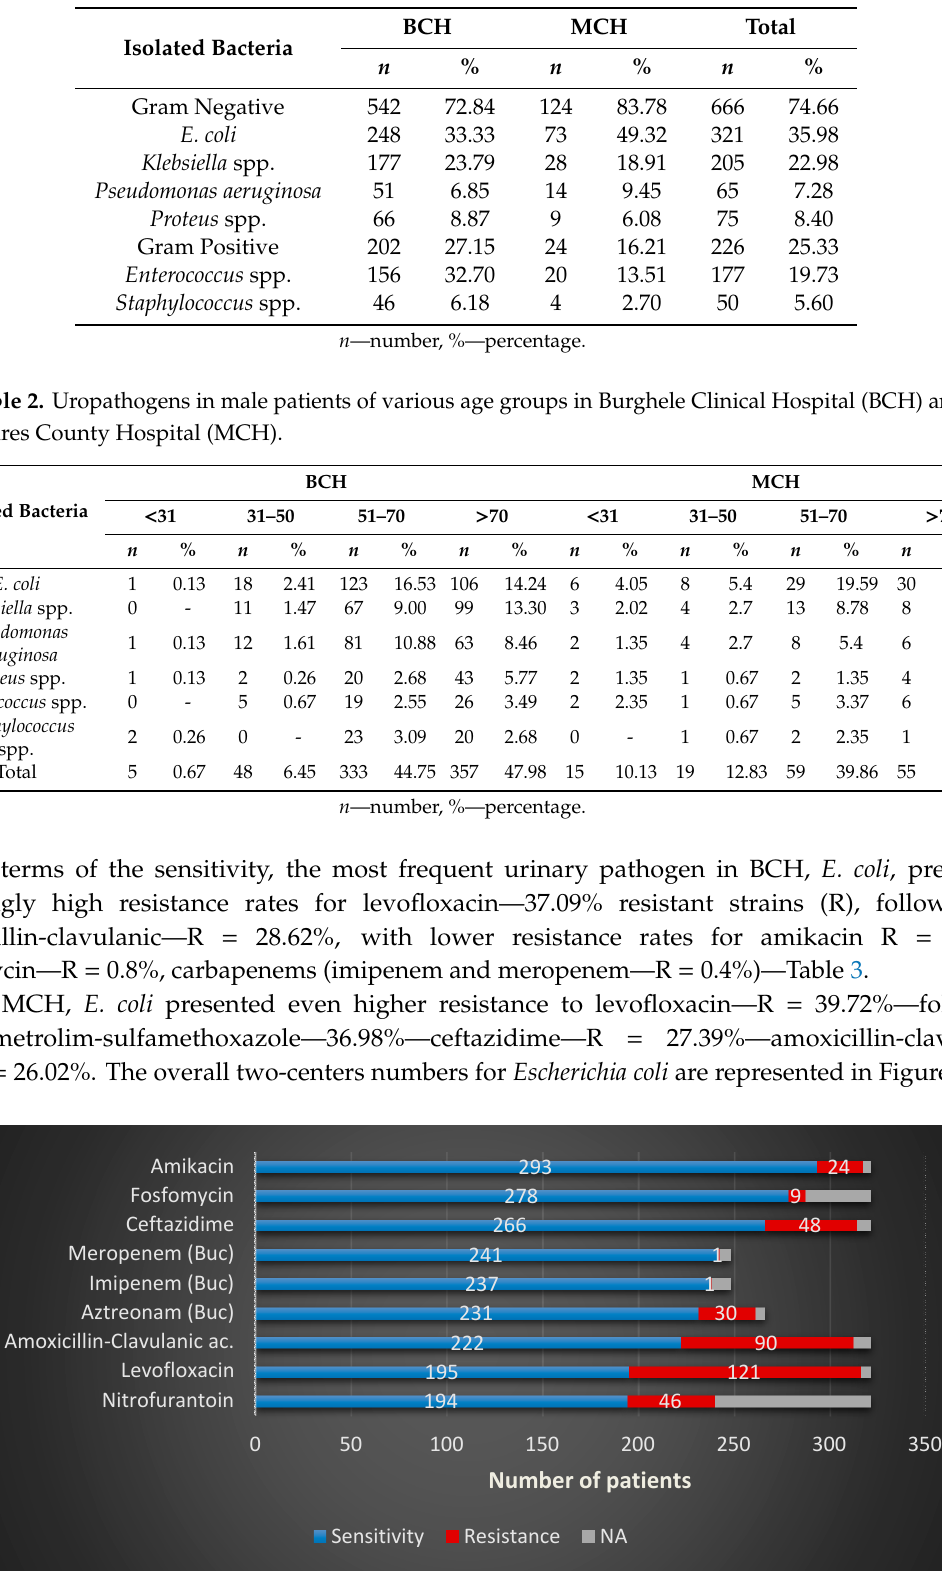
Table 1. Isolated uropathogens in the study group.